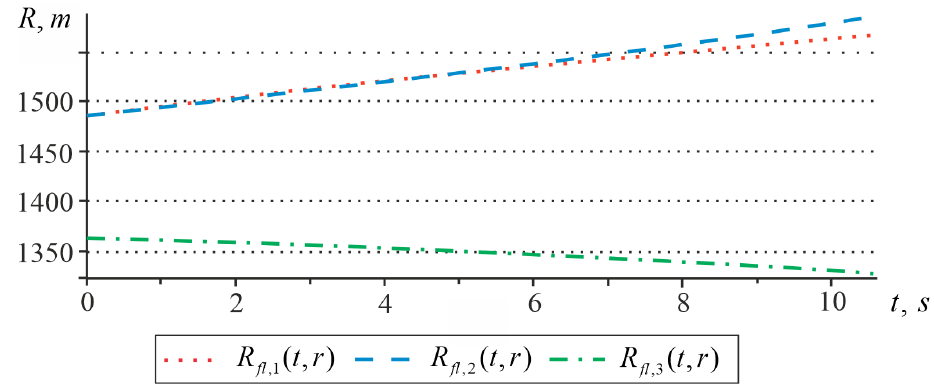
10 of 16 Figure 7. Height estimation (first simulation). In the case of the flight height uniformly increasing, the absolute values of the veloc- ity along each of the beams (Figure 5) did not correspond to the absolute velocity value. However, by analyzing Figure 6, one can see that the estimation of the velocity vector components during uniform movement was close to the true values, and the absolute er- ror was less than 1.5%. We performed a range estimation according to Equation (12). The obtained results also corresponded to the stated initial data in the simulation. Considering more complex helicopter flight trajectories when the yaw, attack, and